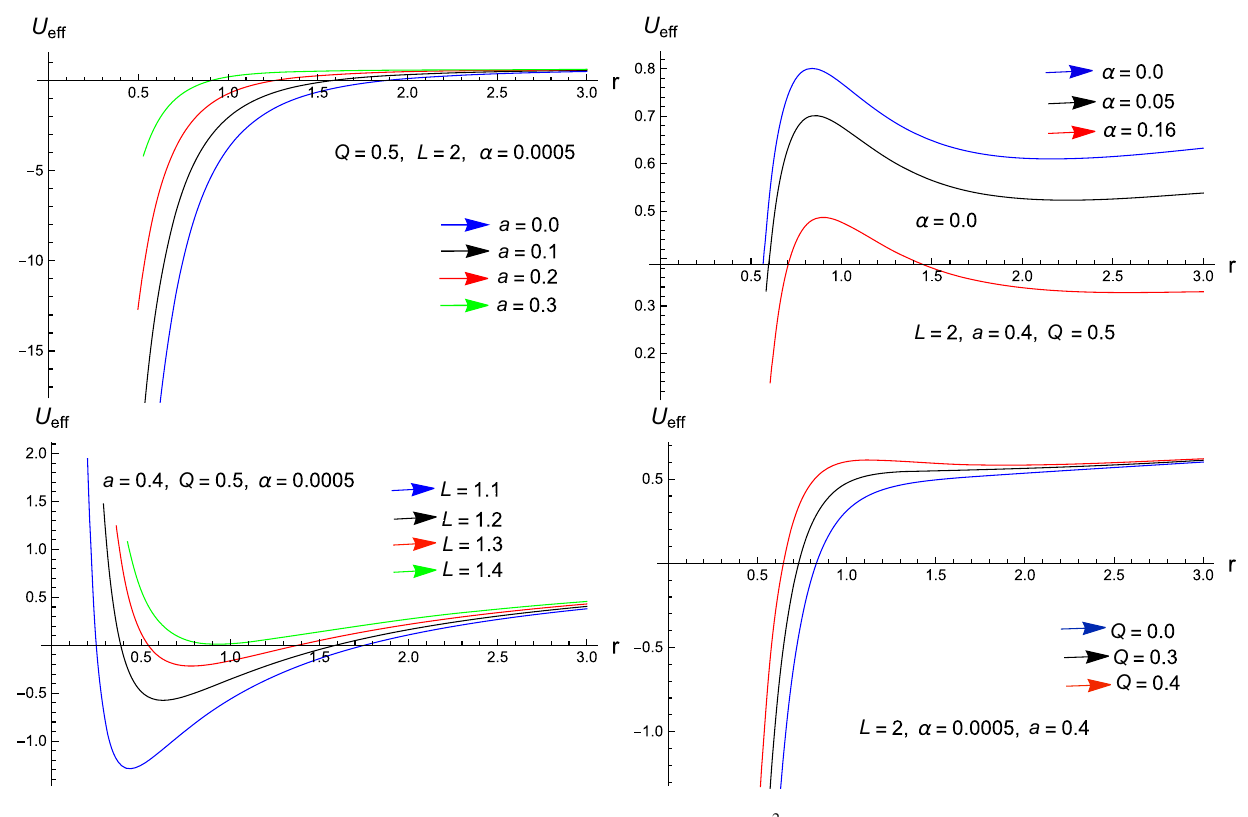
Fig. 5 Plots of effective potential for time-like geodesics as a of function of r for ω = − 2